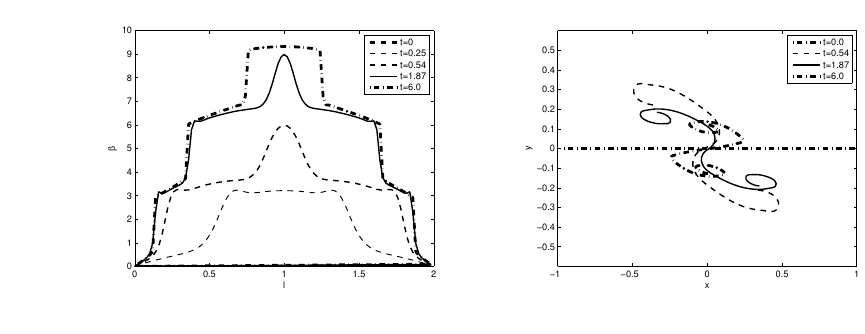
Figure 11. Droplet dynamics at ωτ = 0 ⇒ 12, t f = 6.